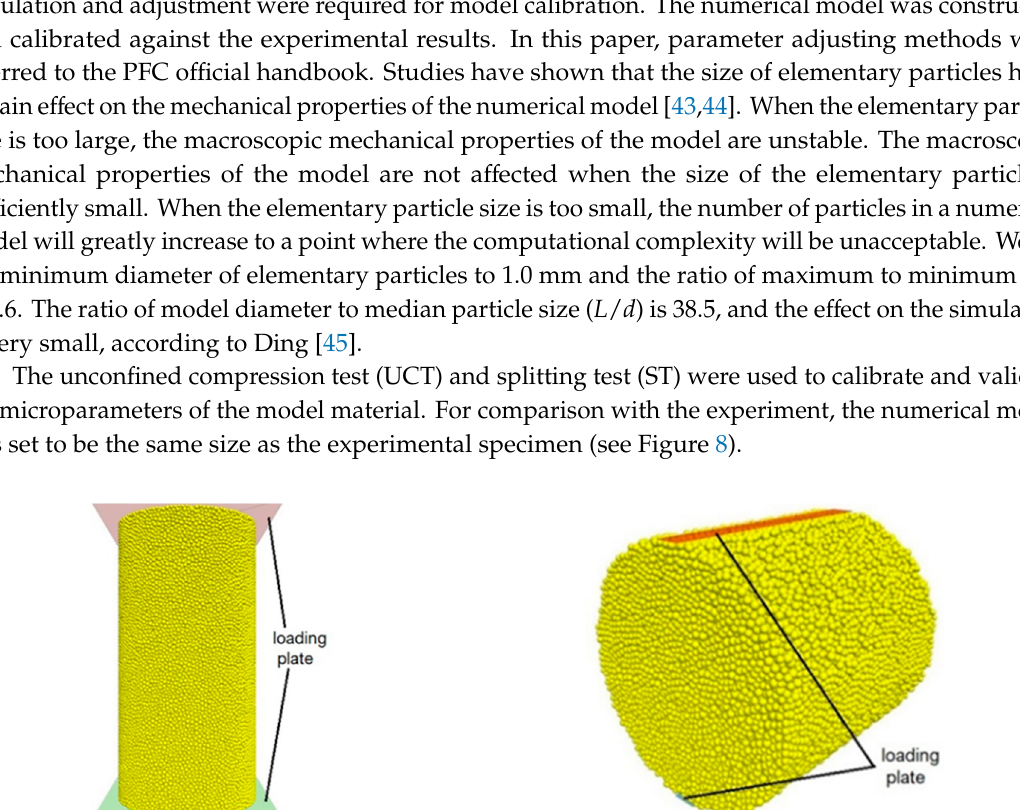
Figure 7. A typical flat-joint contact. Figur e 7 . A typical flat-joint contact